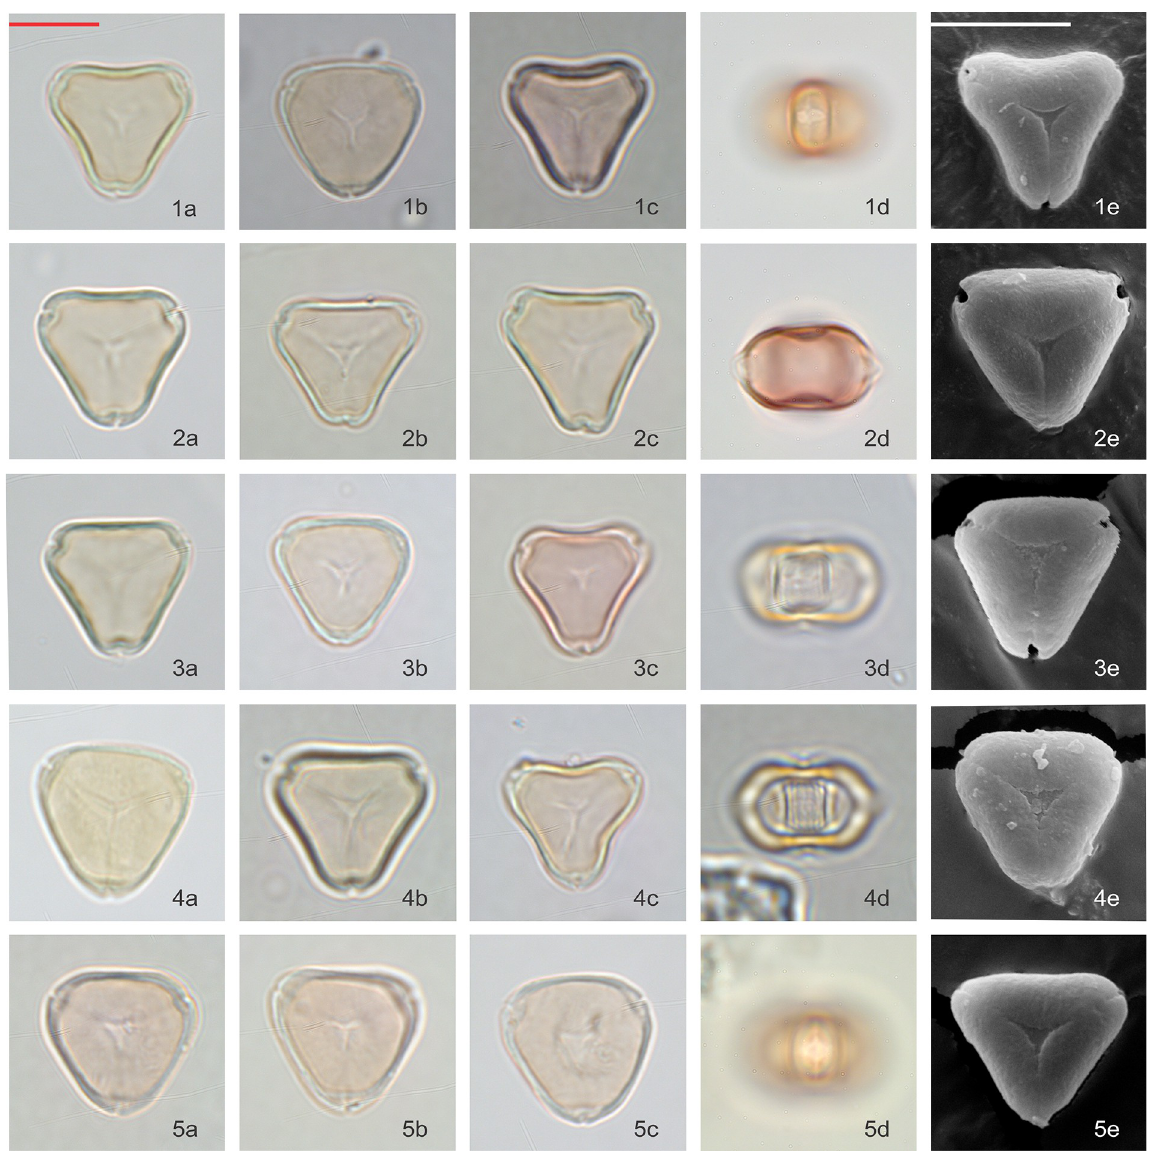
Fig 7. Polar and equatorial views of Kunzea , Part 2. Scale bar = 10 μ m. (1a-1e) K . linearis , (2a-2e) K . tenuicaulis , (3a-3e) K . salterae , (4a-4e) K . robusta , (5a-5e) K . triregensis